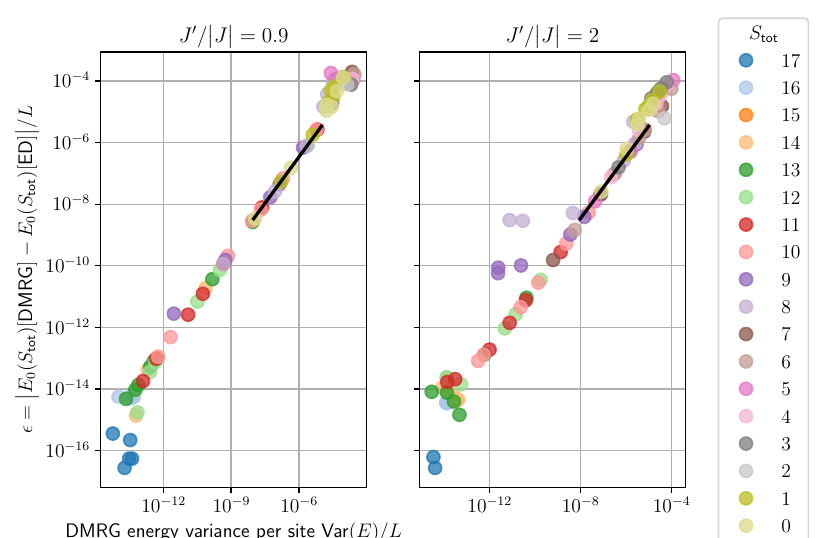
/ L computed using DMRG with the 0 (cid:12) (cid:12) (cid:12) J (cid:12) = 0.9 , which corresponds to SU(2)